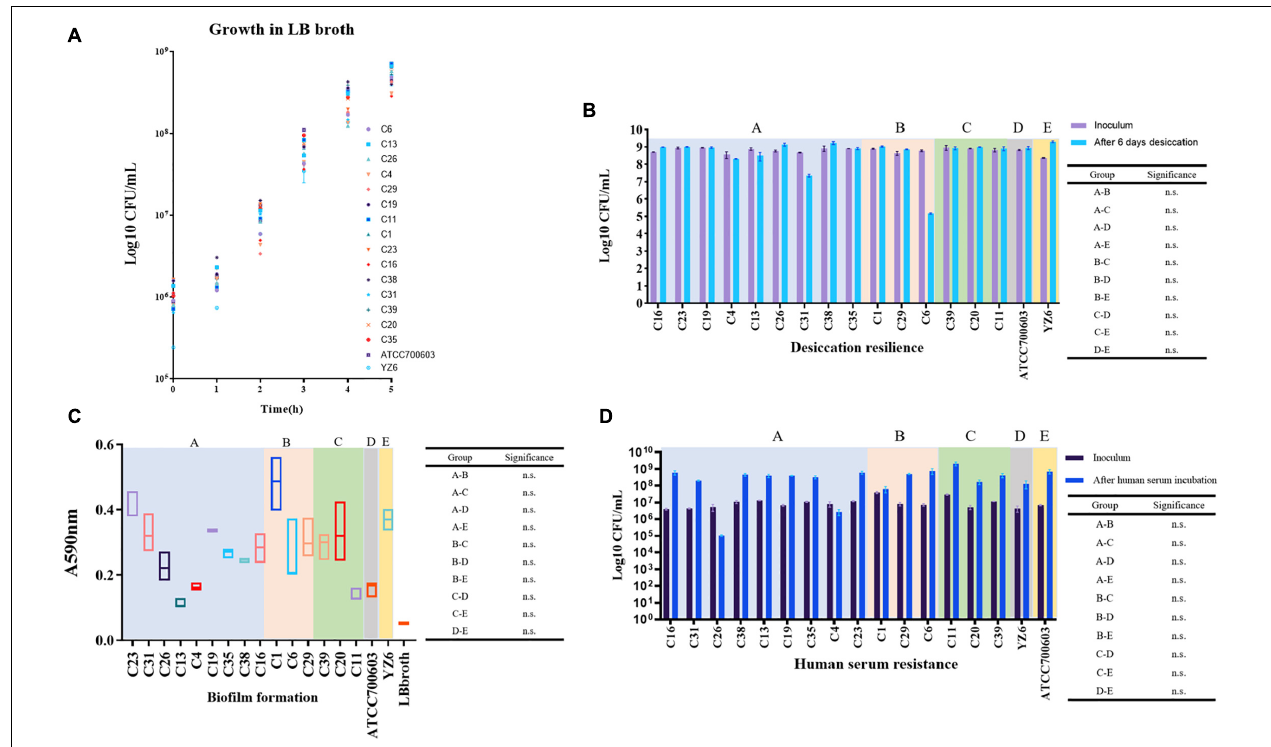
FIGURE 6 | Results of phenotypic experiments to evaluate the fitness and viability of CRKP. Five groups with background color in pale purple ( A: bla KPC − 2 -ST11 group), light pink ( B: bla KPC − 2 -ST15 and ST2237 group), green ( C: bla NDM − 1 -positive group), gray ( D: standard strain ATCC700603), and yellow ( E: YZ6), respectively. (A) Growth conditions of CRKP and control isolates over 5 h. (B) Comparison of the changes of CRKP and control isolates amount during desiccation. n.s., not significant. (C) Biofilm formation of CRKP and control isolates; the value represents the absorbance values at 590 nm. n.s., not significant. (D) Comparison of the changes of CRKP and control isolates amount incubation in human serum for 4 h. n.s., not